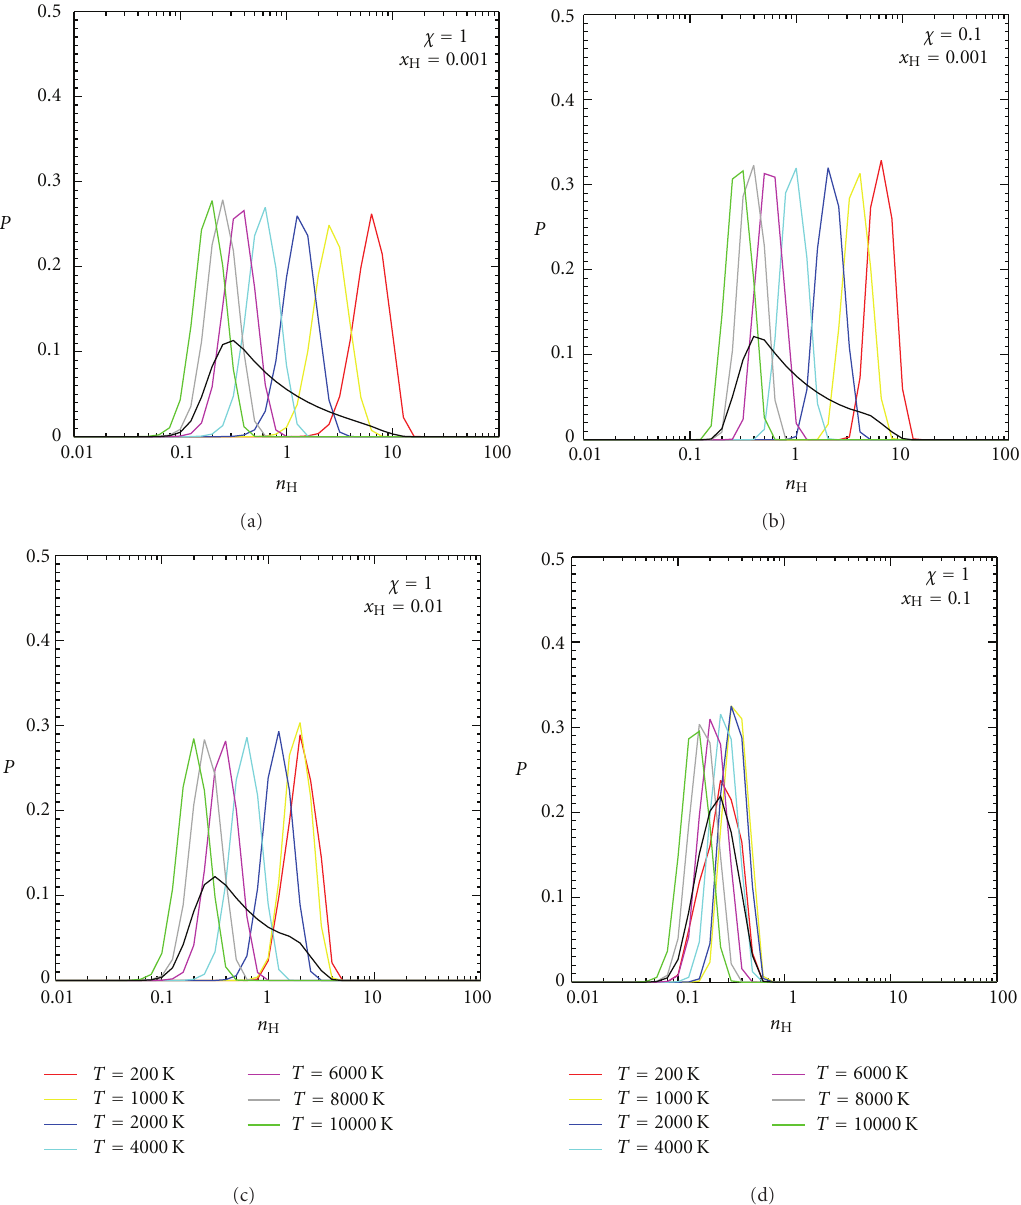
Figure 5: Colored lines: likelihoods for n H for di ff erent values of T as detailed in the legend; black line: likelihood for n H marginalized over T . (a) x = 0 . 001, χ = 1; (b) same as (a) with χ = 0 . 1; (c, d): same as (a) with x H